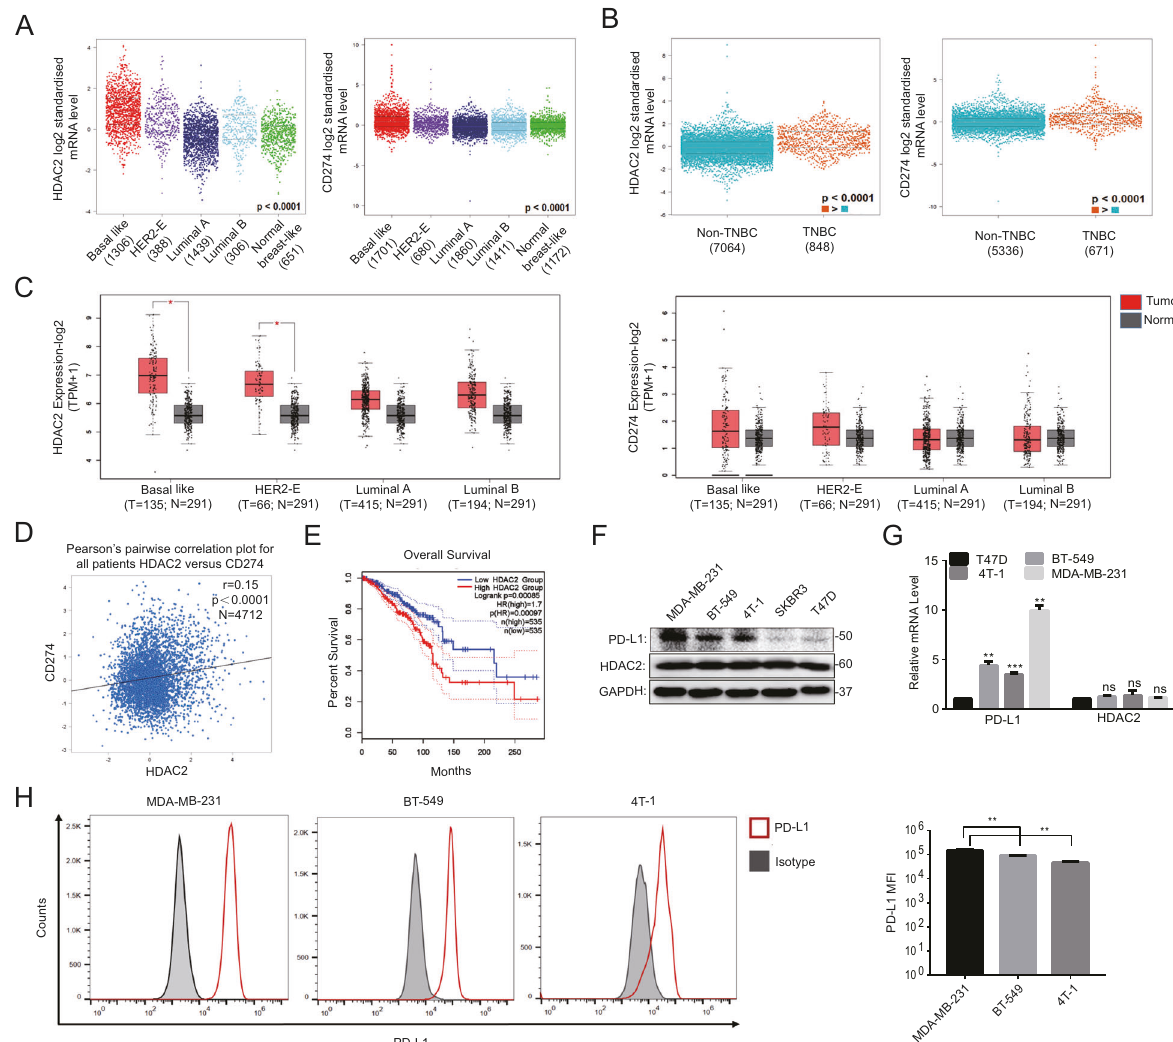
Fig. 1 The HDAC2 and PD-L1 expression was higher in TNBC than that in other breast cancer subtypes. A , B The bc-GenExMiner v 4.5 analysis for HDAC2 and PD-L1 expression in different breast cancer subtypes ( A ), as well as in TNBC and non-TNBC subtypes ( B ). C The HDAC2 and PD-L1 expression between normal and breast cancer tissues was determined by GEPIA2. D The correlation between HDAC2 and PD-L1 expression was analyzed by bc-GenExMiner v 4.5. E The relationship between HDAC2 expression and the prognosis of breast cancer patients was determined by GEPIA2. F , G Western blotting ( F ) and RT-PCR ( G , n = 3) detected the HDAC2 and PD-L1 expression in the cells of breast cancer. H The fl ow cytometry results showed the cell surface expression of PD-L1 in TNBC cells ( n =